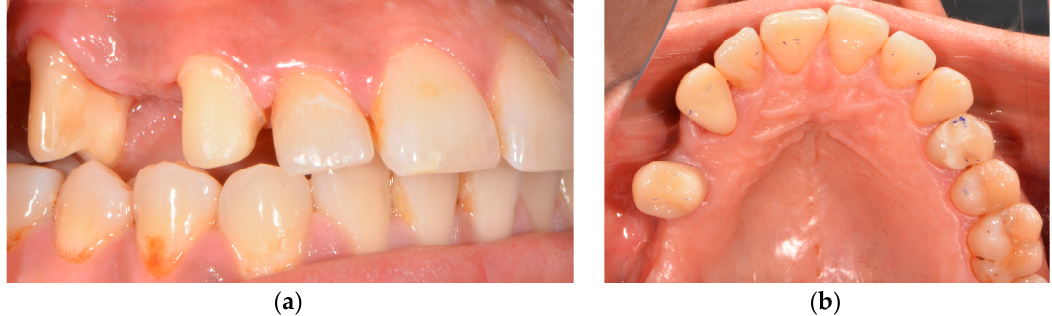
Figure 1. Initial situation: ( a ) lateral view: tooth 15 and 13 already prepared and tooth 14 missing